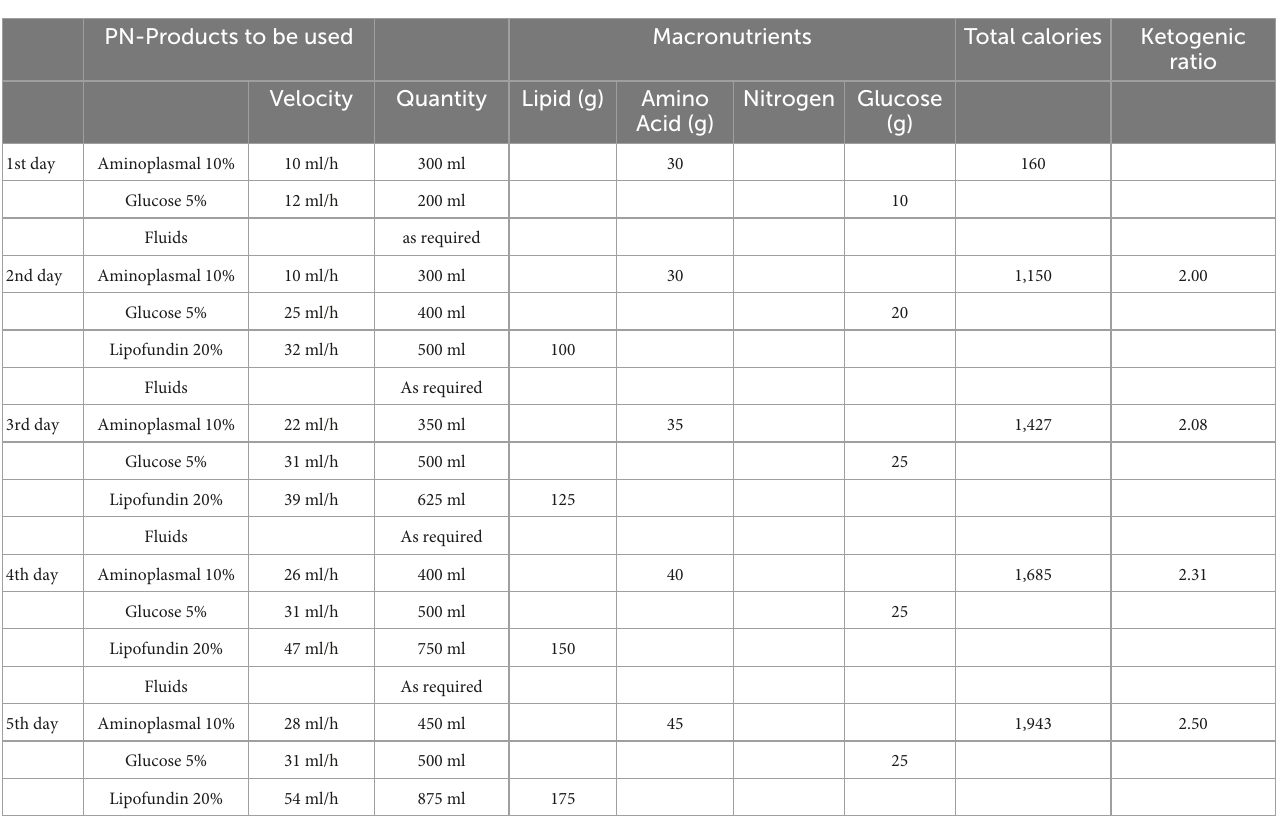
TABLE 2 Timeline of Theoretical plan for Parenteral and Enteral Nutrition (PEN) management. PN-Products to be